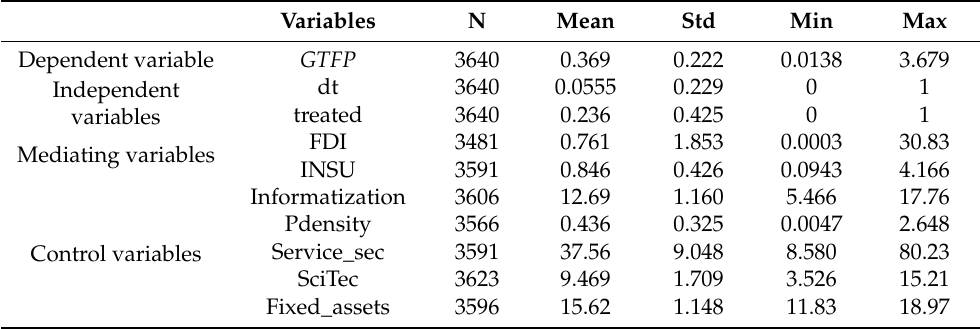
Table 3. Descriptive